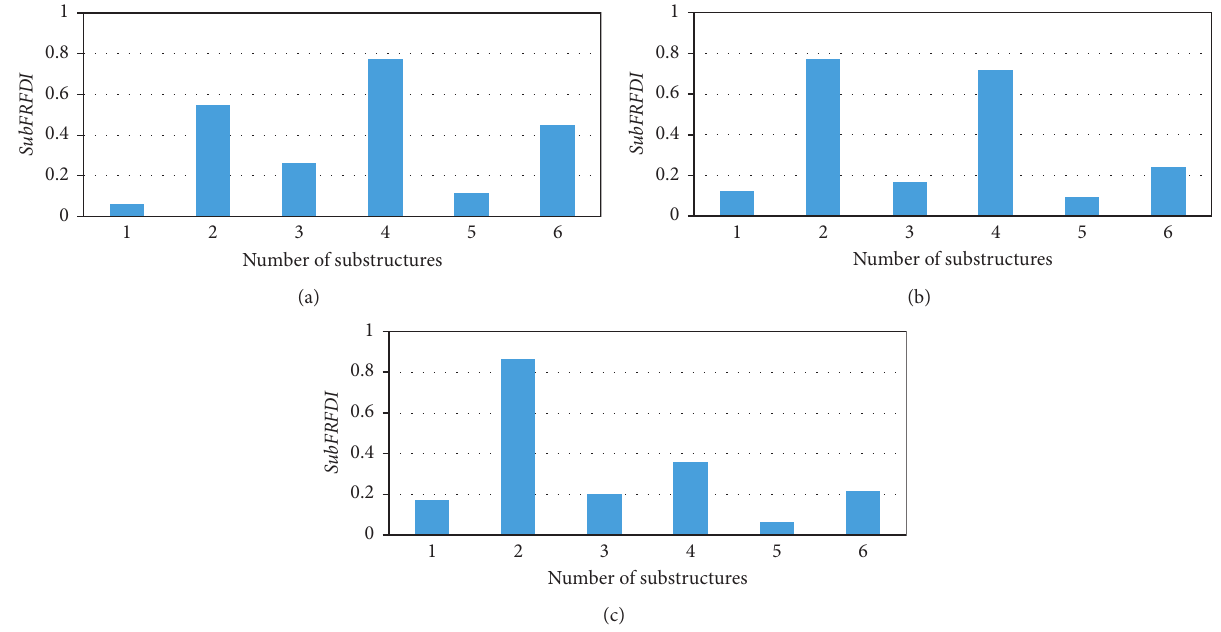
Figure 15: SubFRFDI values for (a) case Dam_2F5%&4F15%&6F10%, (b) case Dam_2F10%&4F15%&6F5%, and (c) case Dam_2F15% &4F10%&6F5%.